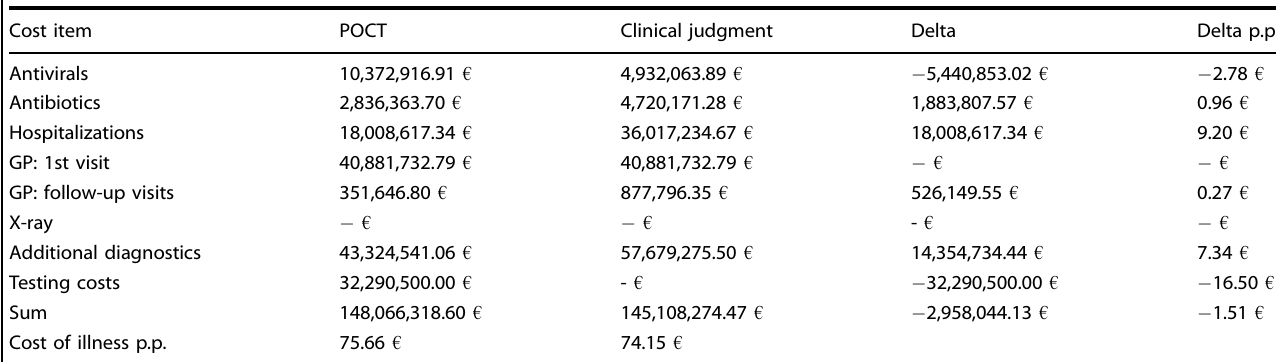
Table 5. Calculation (age-group speci fi c)